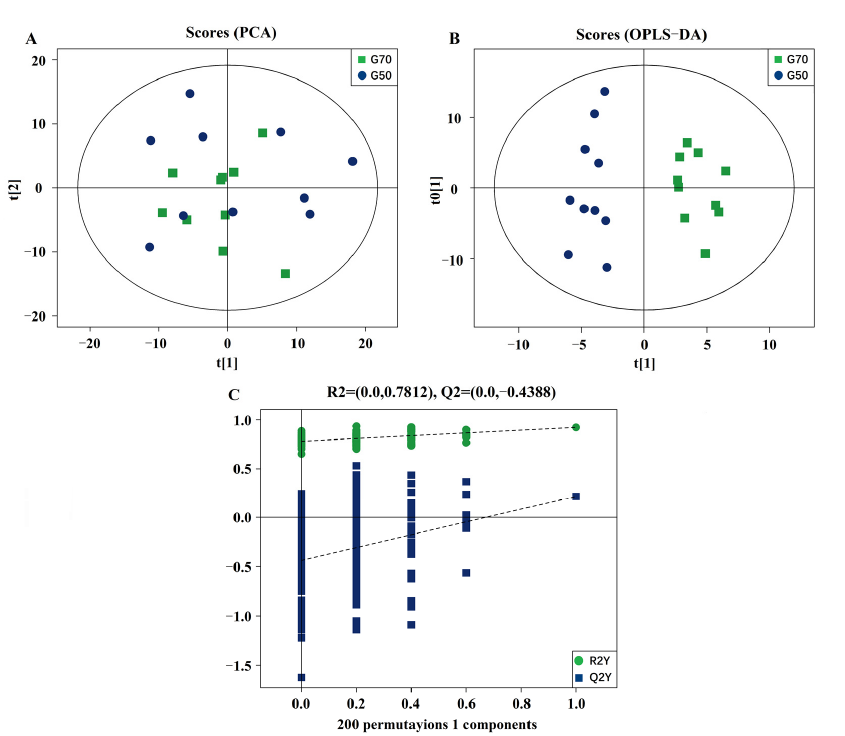
Figure 1. Data modeling and selection of differentially expressed lipid metabolites of yolk on E22 from eggs at a 50 ◦ or 70 ◦ turning angle. ( A ) Principal component analysis (PCA) of the normalized peak areas of individual metabolites. ( B ) OPLS-DA differentiation of the lipid metabolites of yolk from eggs at a 50 ◦ or 70 ◦ turning angle. ( C ) Validation of OPLS-DA results based on 200 permutation tests. OPLS-DA, orthogonal projections to latent structures-discriminate analysis. PCA and OPLS-DA analysis were measured with SIMCA14.1 software V14.1 (Sartorius Stedim Data Analytics AB, Umea,